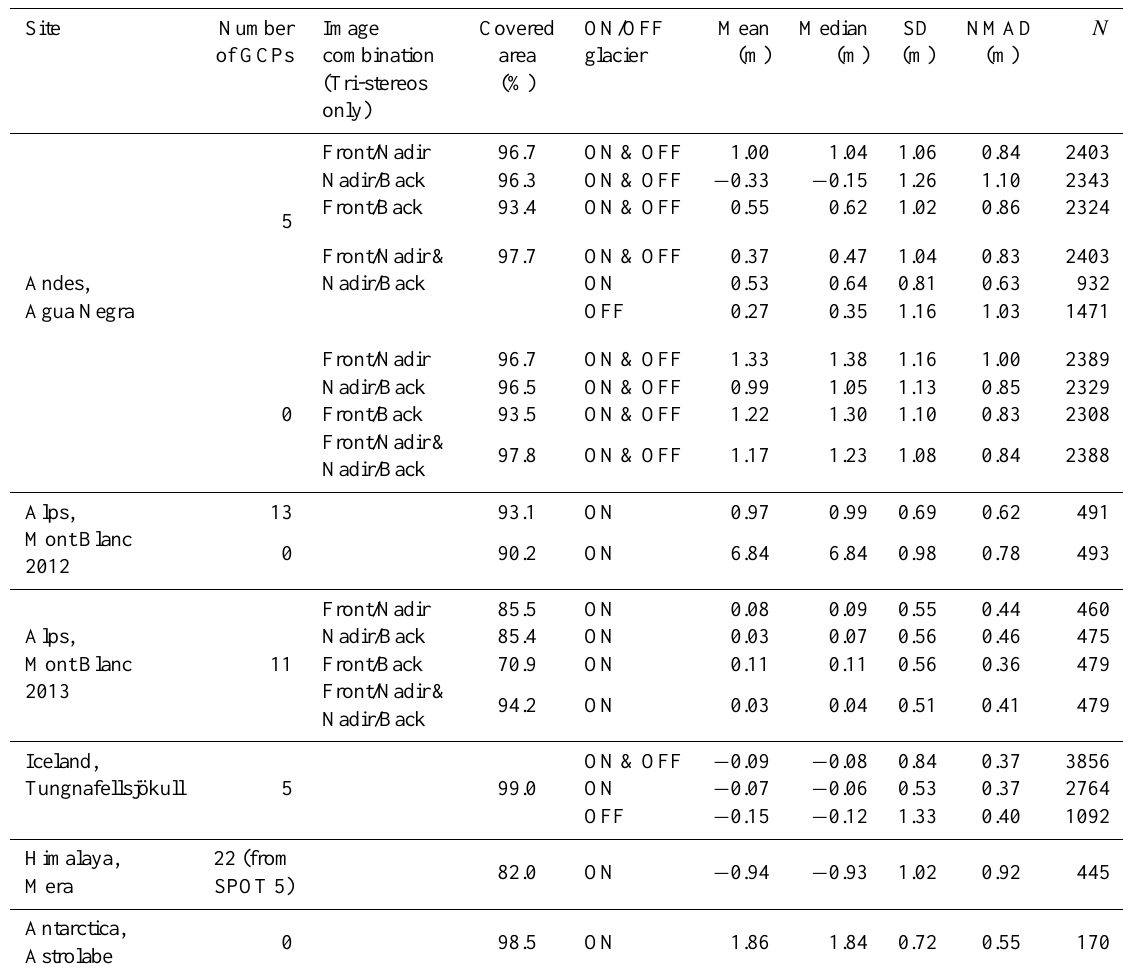
Table 4. Statistics on the elevation differences between the Pléiades DEMs and the GNSS measurements for all study sites. When a tri-stereo was available, the statistics for the three different image combinations and for a merged DEM are given. For Agua Negra and Tungnafell- sjökull, the statistics are also given separately on and off glaciers. The last column, N , indicates the number of points for which elevation differences are